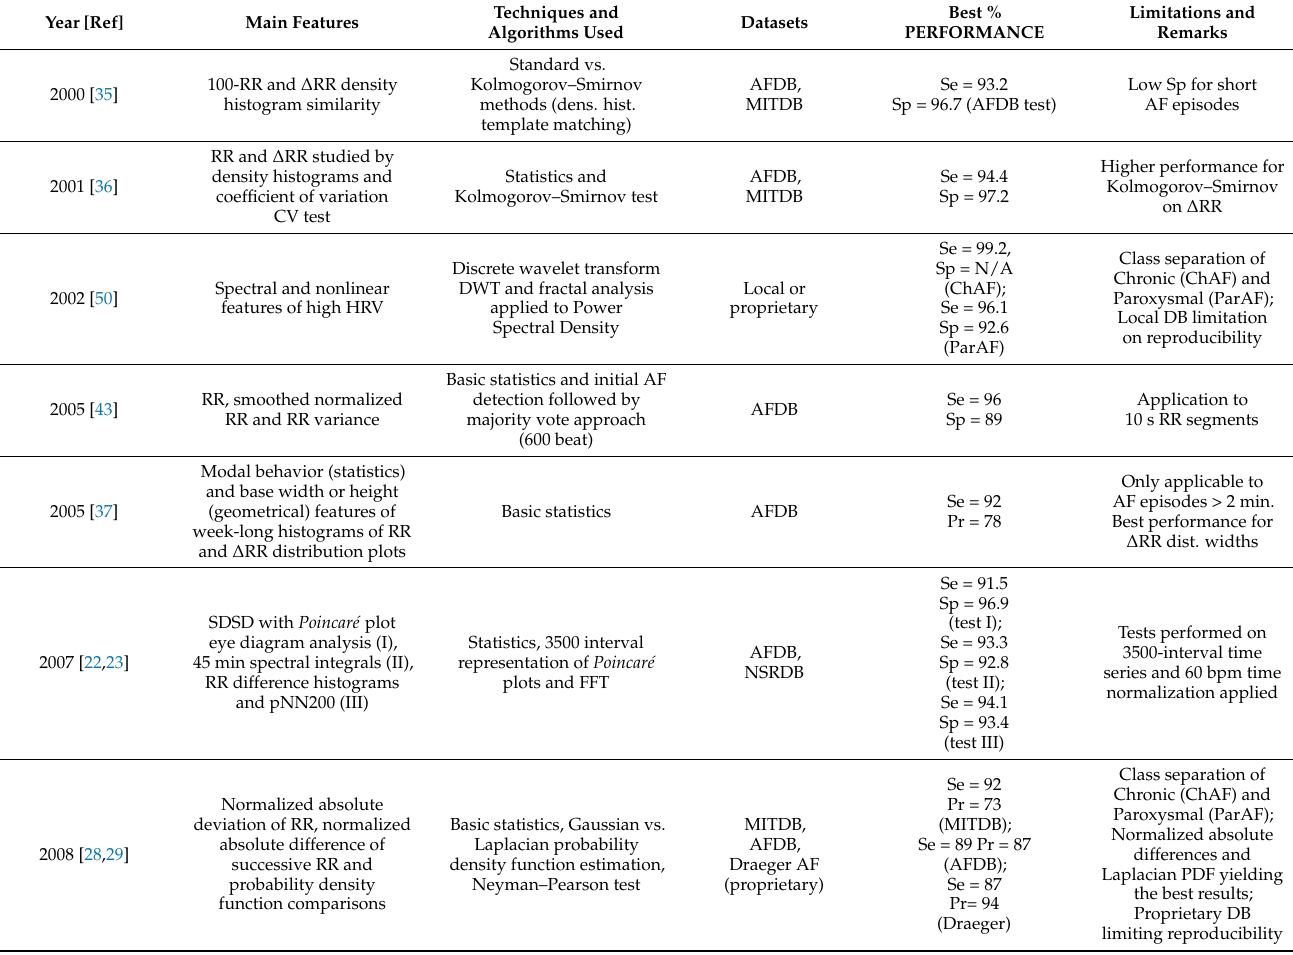
Table 2. SummaryofchosenunivariateAFresearchstudiespublishedafteryear2000,